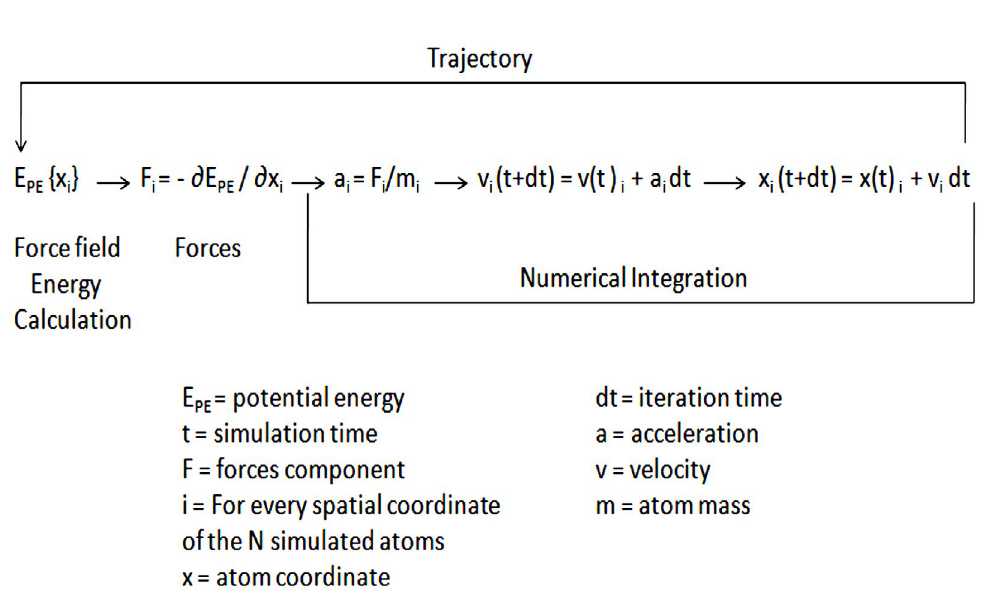
Fig. 12. A Basic algorithm for Molecular